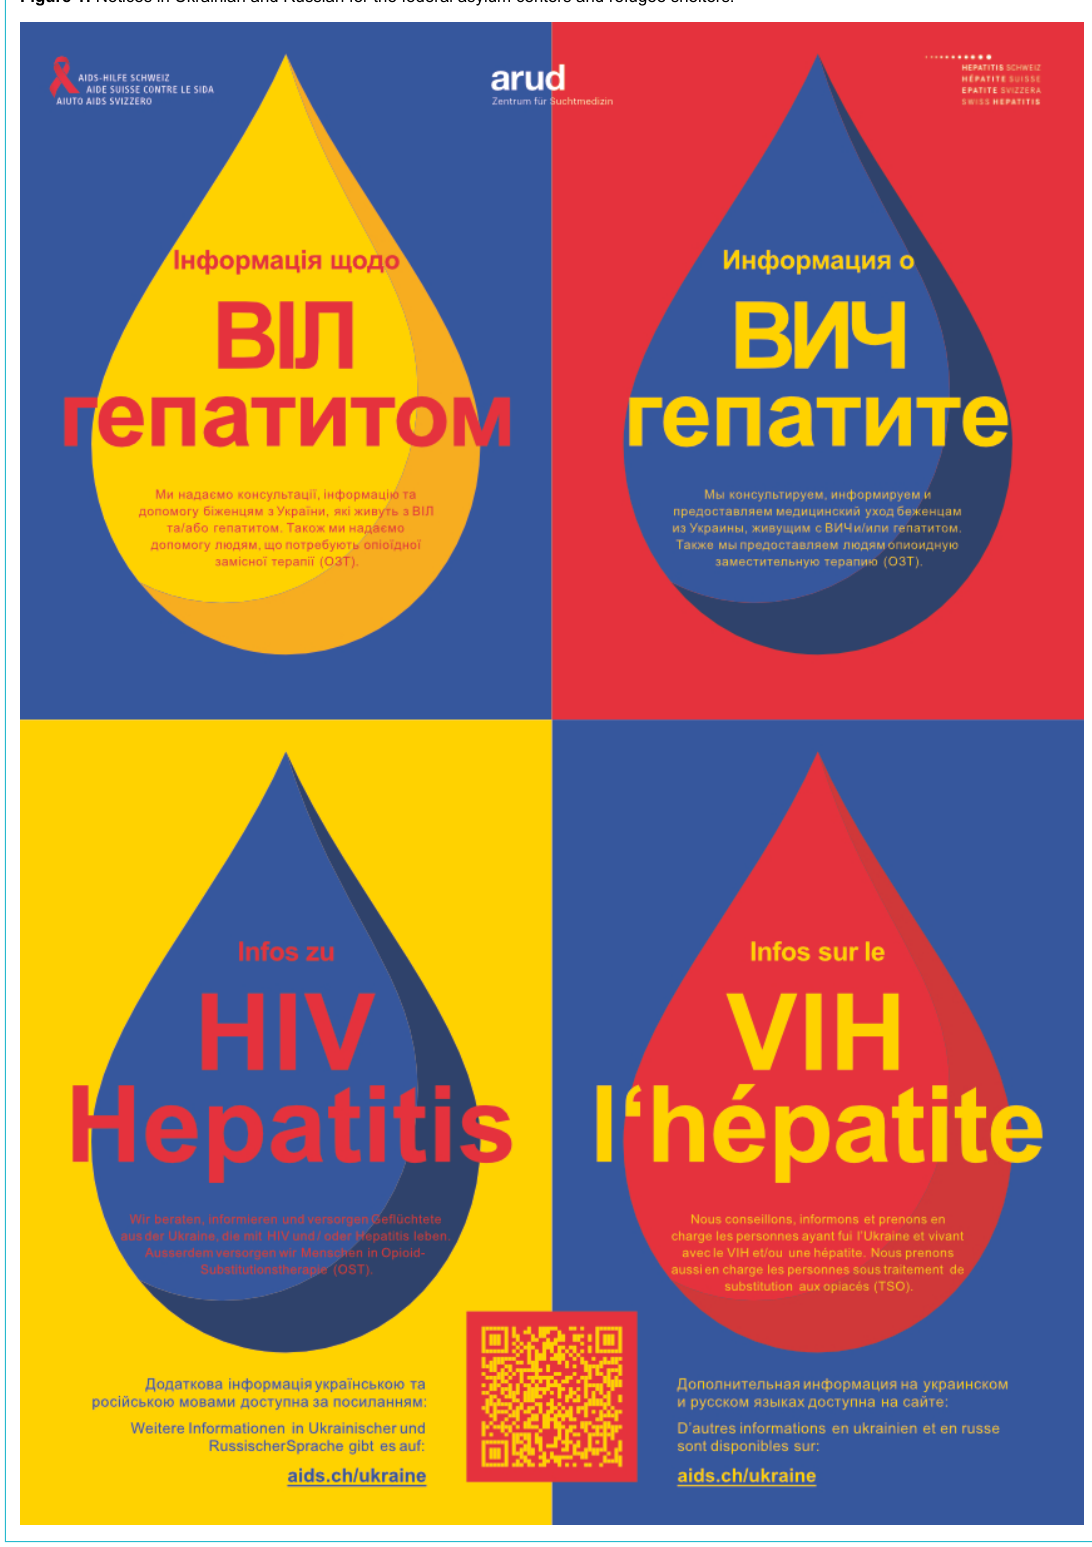
Figure 1: Notices in Ukrainian and Russian for the federal asylum centers and refugee